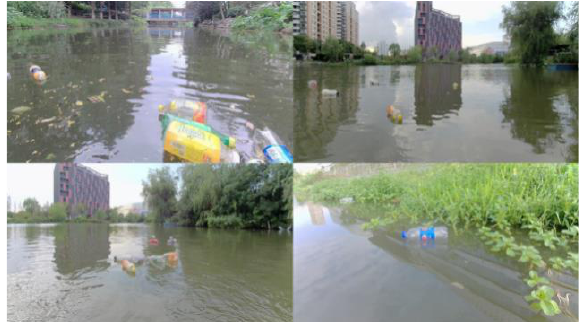
Figure 13. Sample images of the FloW-Img public dataset used in the experiments.